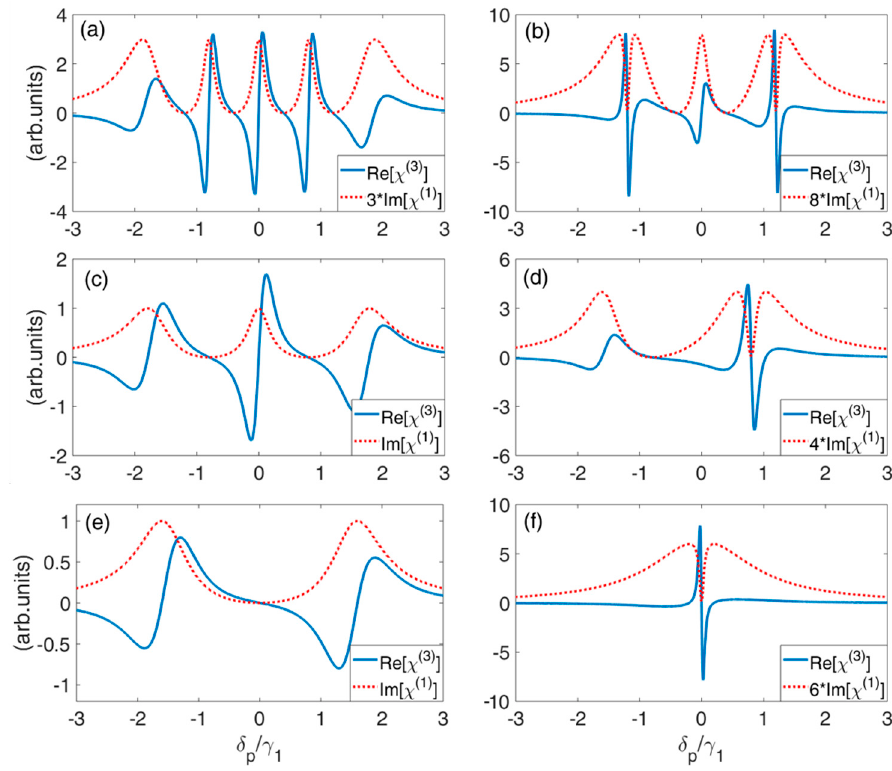
Figure 4. Linear absorption Im χ ( 1 ) χ ( 3 ) and self-Kerr nonlinearity Re as a function of probe detuning δ p for varying tunneling coupling and energy splitting. ( a ) ω 12 = − 1.2 γ 1 , ω 13 = − 0.4 γ 1 , ω 14 = 0.4 γ 1 , ω 15 = 1.2 γ 1 , T 3 = T 4 = 0.8 γ 1 , T 2 = T 5 = 0.8 γ 1 ; ( b ) the parameters are the same